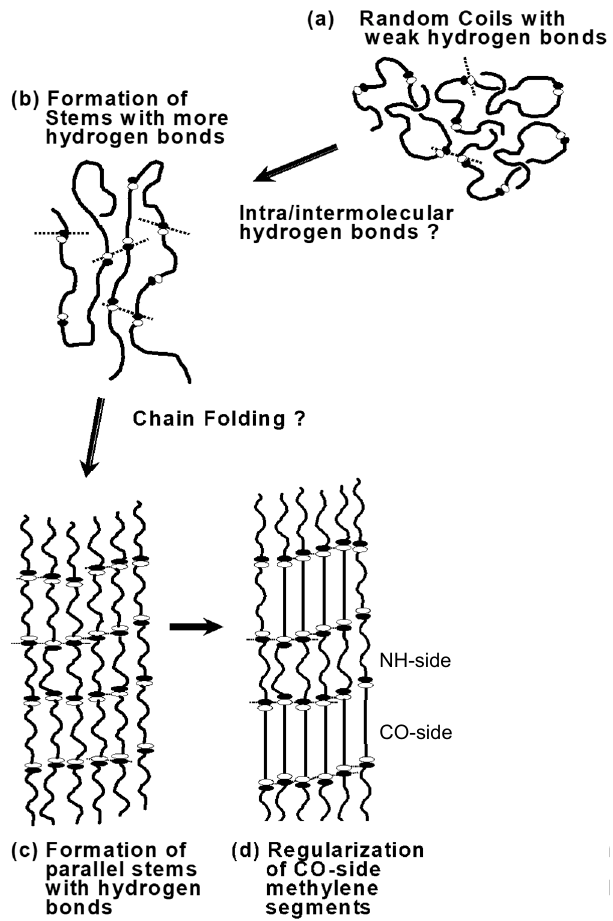
Figure14. Schematicillustrationofthestructuralevolutionofnylon1010intheisothermalcrystallization Figure 14. Schematic illustration of the structural evolution of nylon 1010 in the isothermal process from the crystallization process from the melt.